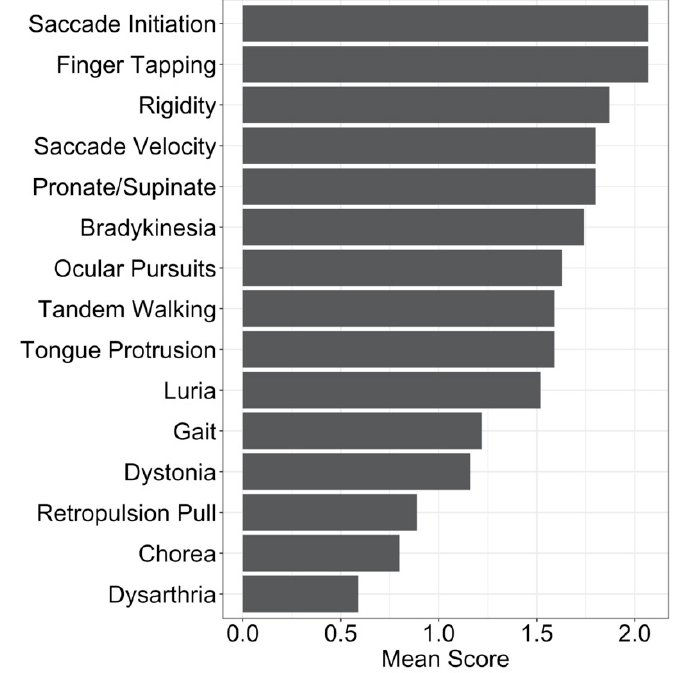
Figure 1. Mean scores on the various domains of the Unified Huntington’s Disease Rating Scale (UHDRS). Specifically, ocular pursuit score is the mean of horizontal and vertical pursuit scores; saccade initiation is the mean of the horizontal and vertical initiation scores; saccade velocity is the mean of the horizontal and vertical velocity scores; finger tapping is the mean of the right and left hand scores; pronate / supinate is the mean of the right and left hand scores; rigidity is the mean of the scores in the right and left arms; dystonia score is the mean scores from the trunk, right and left upper extremities, and right and left lower extremities; chorea score is the mean of maximal chorea scores from the face, buccal-oral-lingual scores, trunk, right and left upper extremities, and right and left lower extremities. All other scores include only one component and represent the mean of that domain.